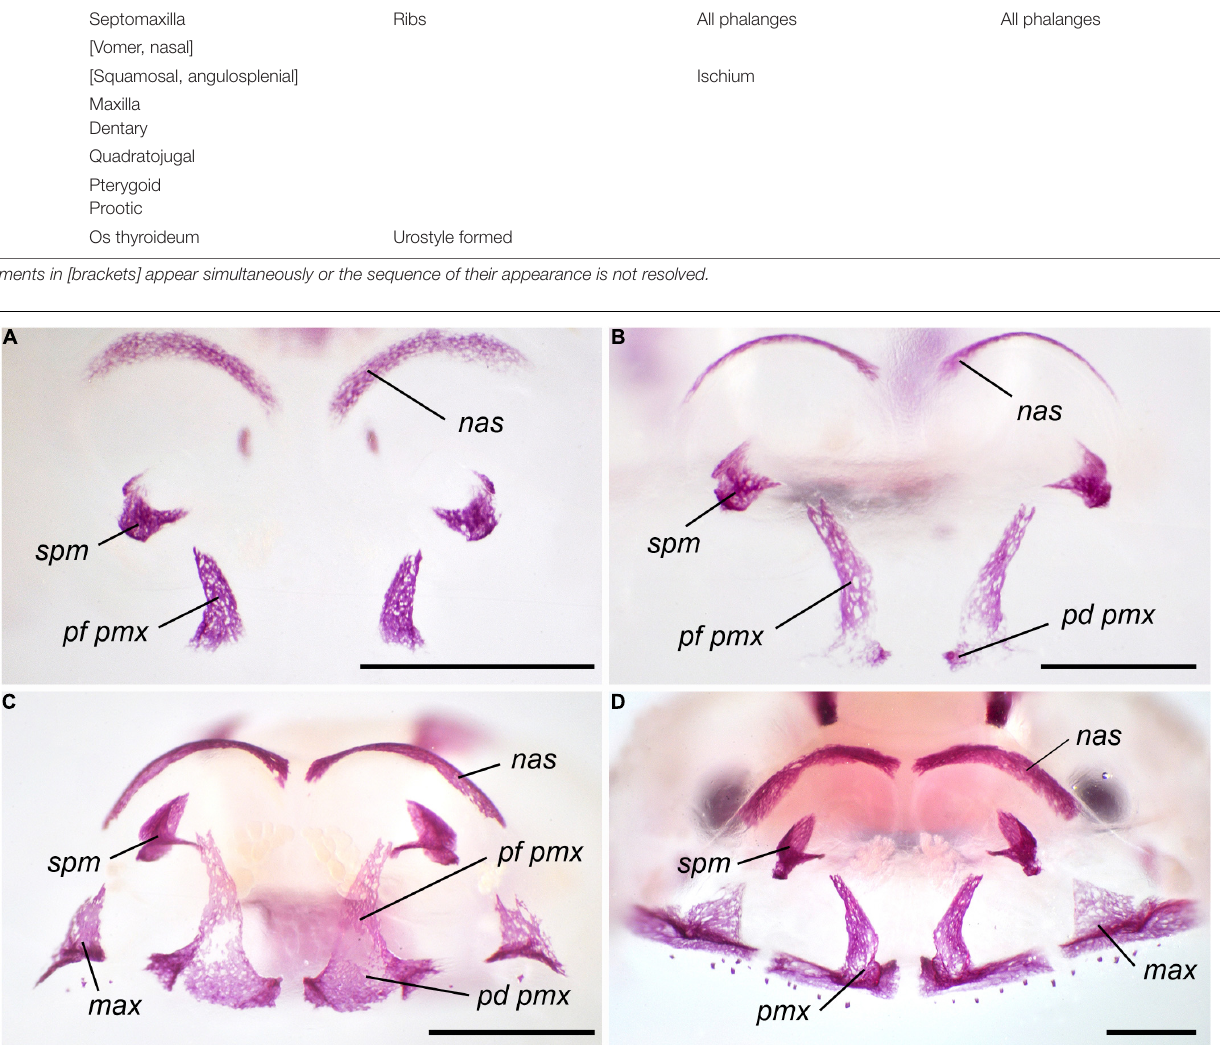
parasphenoid appear after the frontoparietals. The observed variability between Norm I and Norm II is limited mostly to temporal differences; thus, in Norm I, ossification starts on